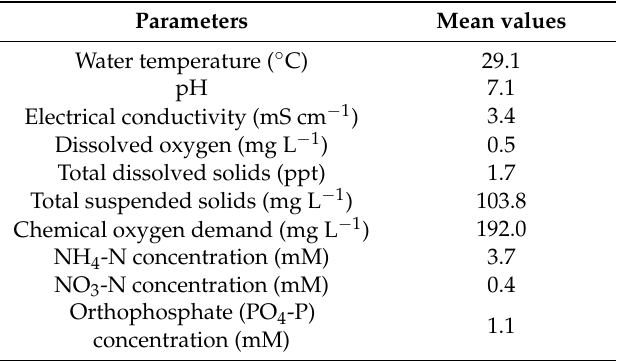
Table 1. Characteristics of anaerobic digester effluent from swine farm.